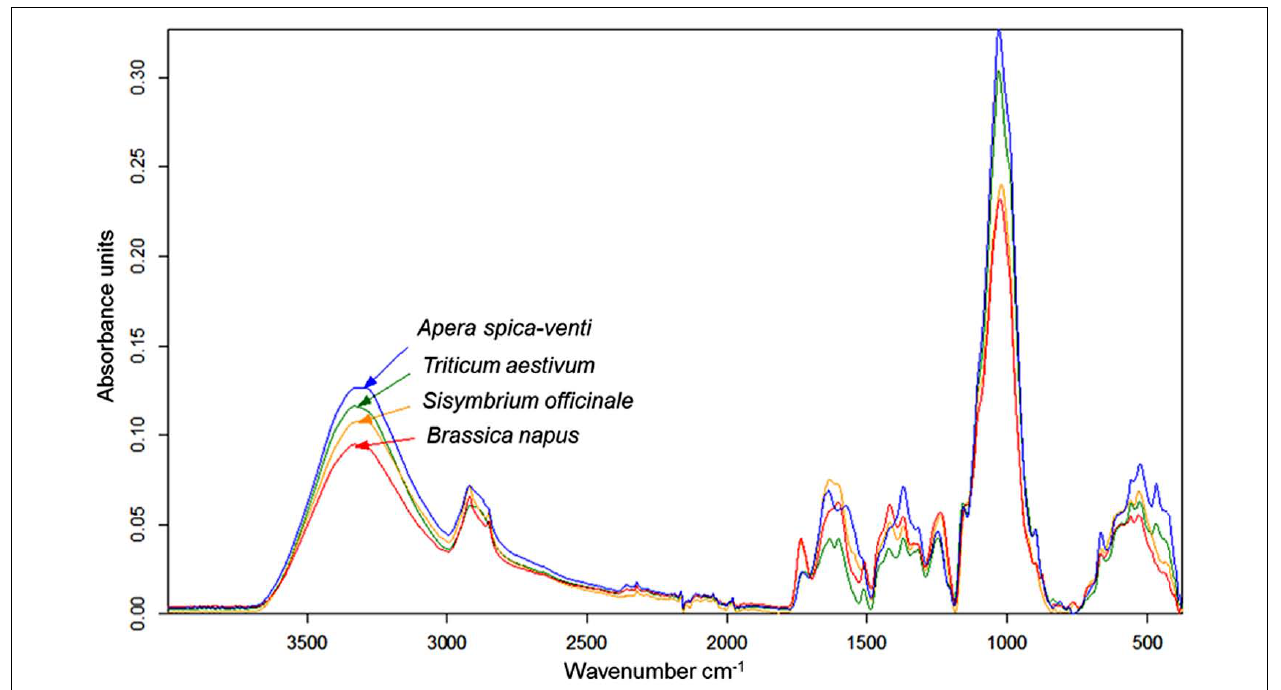
FIGURE 1 | FT-MIR–ATR spectra recorded from dried, ground roots of Triticum aestivum (TA), Apera spica-venti (AS), Brassica napus (BN), and Sisymbrium officinale (SO) grown in a greenhouse experiment. Spectra are means of four replications, vector-normalized and offset-corrected (C. Meinen, unpublished